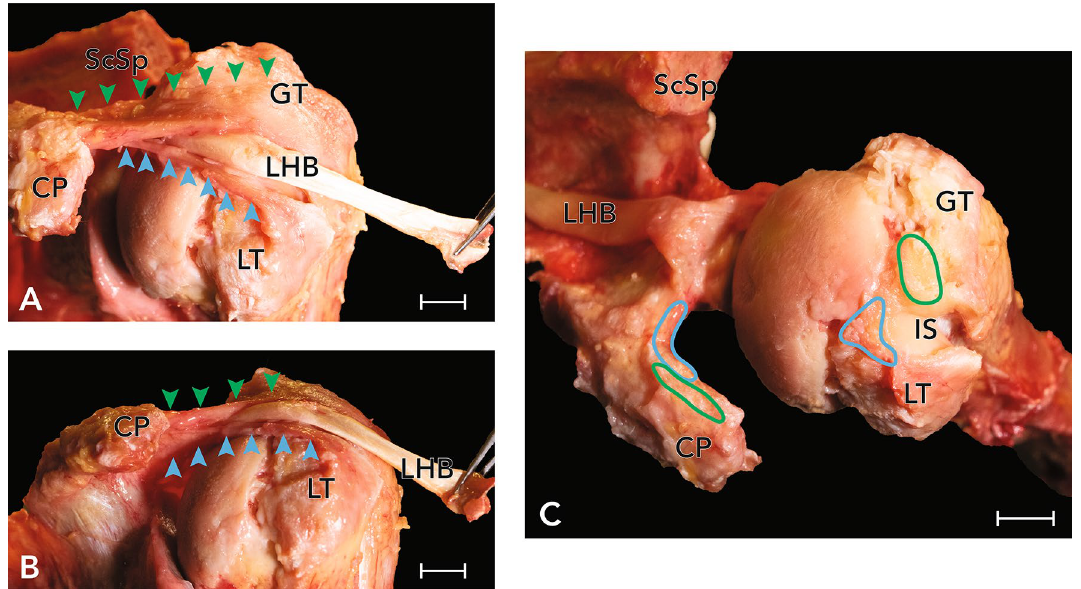
Figure 6. Exemplary view of the morphology of the CHL in a right shoulder. ( A ) view from anterosuperior, ( B ) view from anterior. The two bands—anteromedial (blue arrowheads) and posterolateral (green arrowheads) attached to the lesser and greater tubercle, respectively, are clearly distinguished. The LHB (extracted from the intertubercular sulcus) courses between those bands from its origin at the supraglenoidal tubercle towards the intratubercular sulcus. ( C ) The osseous attachments at the coracoid process and the humerus were marked in the photograph after removal—anteromedial band with blue markings, posterolateral band with green markings. CP coracoid process, ScSp scapular spine, GT greater tubercle, LT lesser tubercle, SSP supraspinatus muscle, SSC subscapularis muscle, LHB long head of the biceps brachii